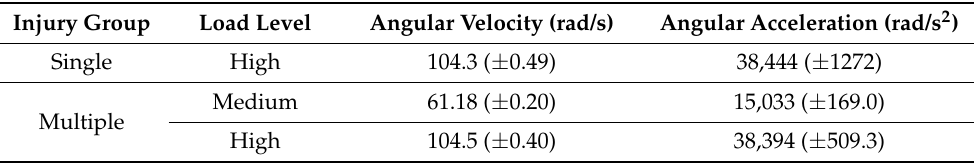
Table 1. Mean ± standard error of angular velocity and angular accelerations for single and multiple RNR loading